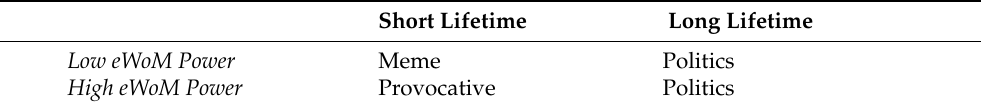
Table 16. Categorization of the posts associated with the lifespan template